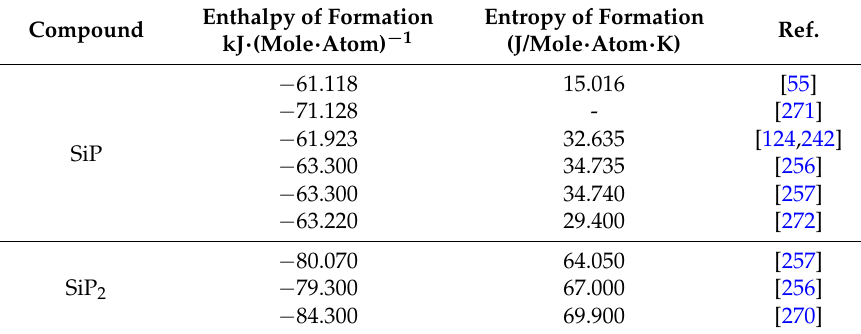
Table 16. The enthalpy and entropy of formation of the P-Si intermetallic